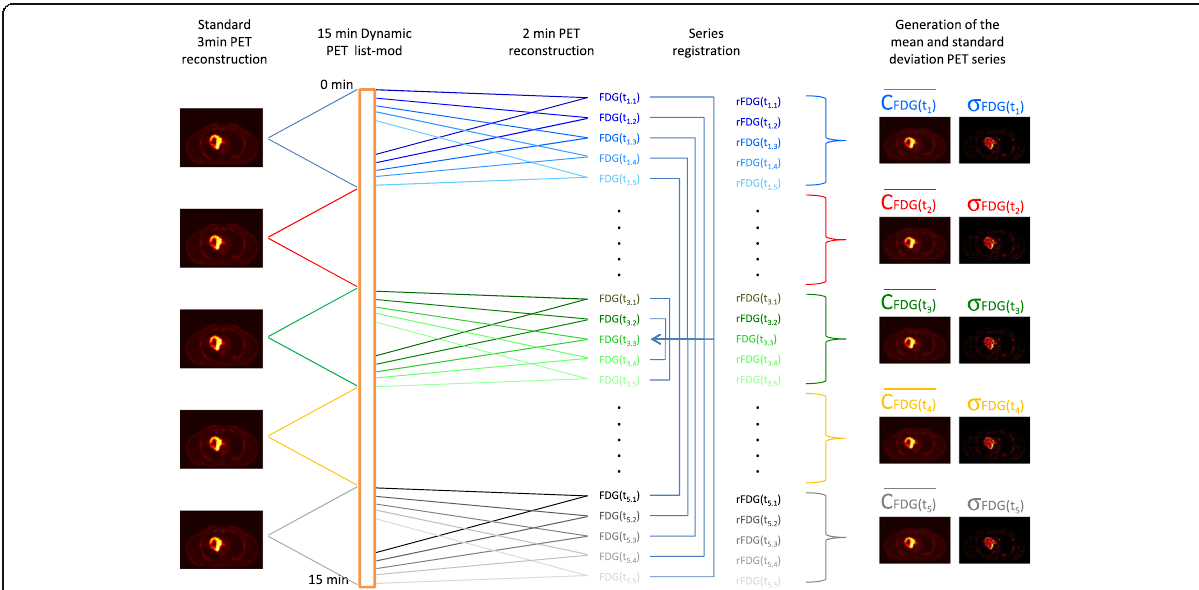
Fig. 2 ParaPET reconstruction scheme. The 15 min dynamic acquisition is rebinned into five series of 3 min listmode datasets. For each 3 min listmode dataset, multiple reconstructions of 2 min are generated to derive C FDG ð t k Þ and σ 2